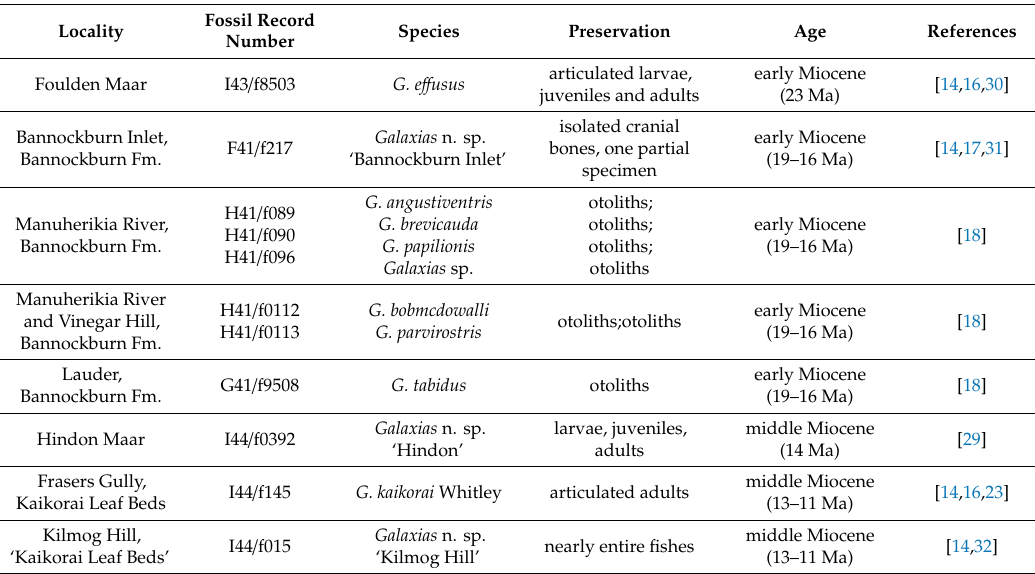
Table 1. Details for Galaxias fossils from New